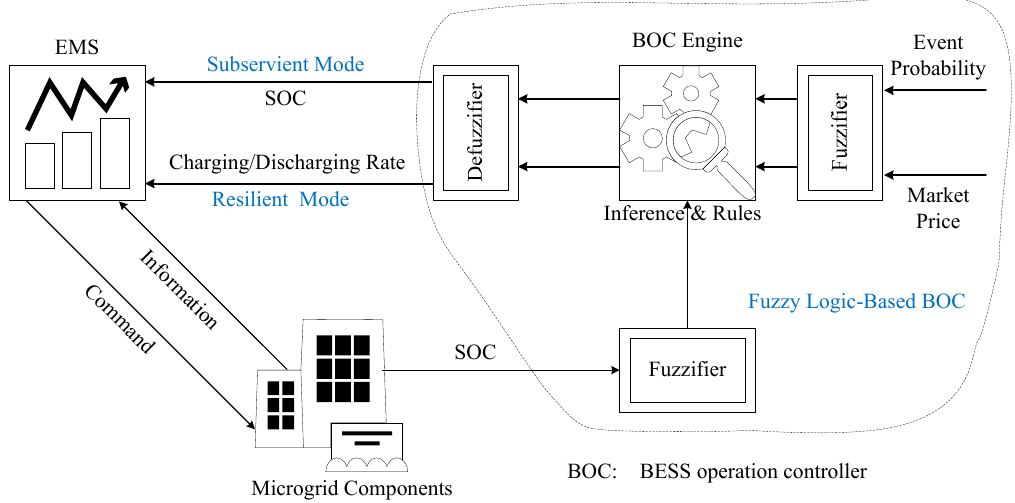
Figure 3. Fuzzy logic-based BESS operation controller.